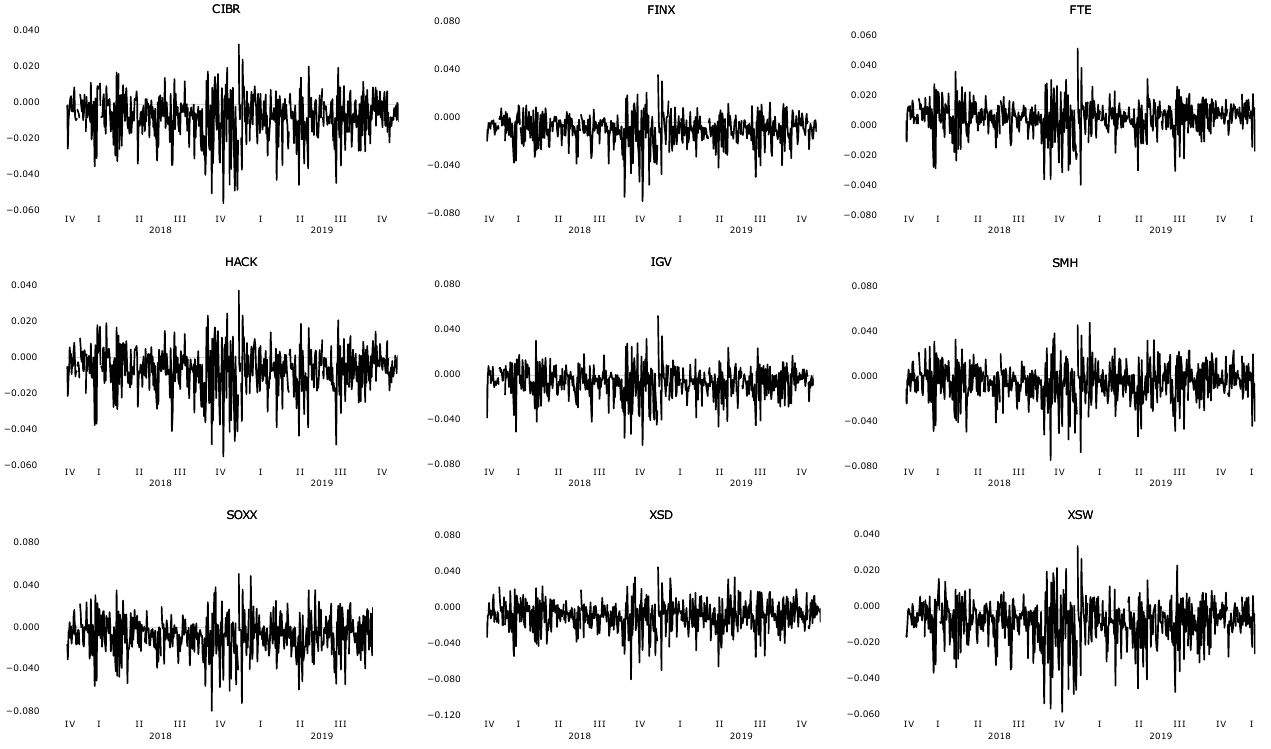
Figure 1. Daily excess returns, high-tech ETFs (12/01/2017-1/31/2020).